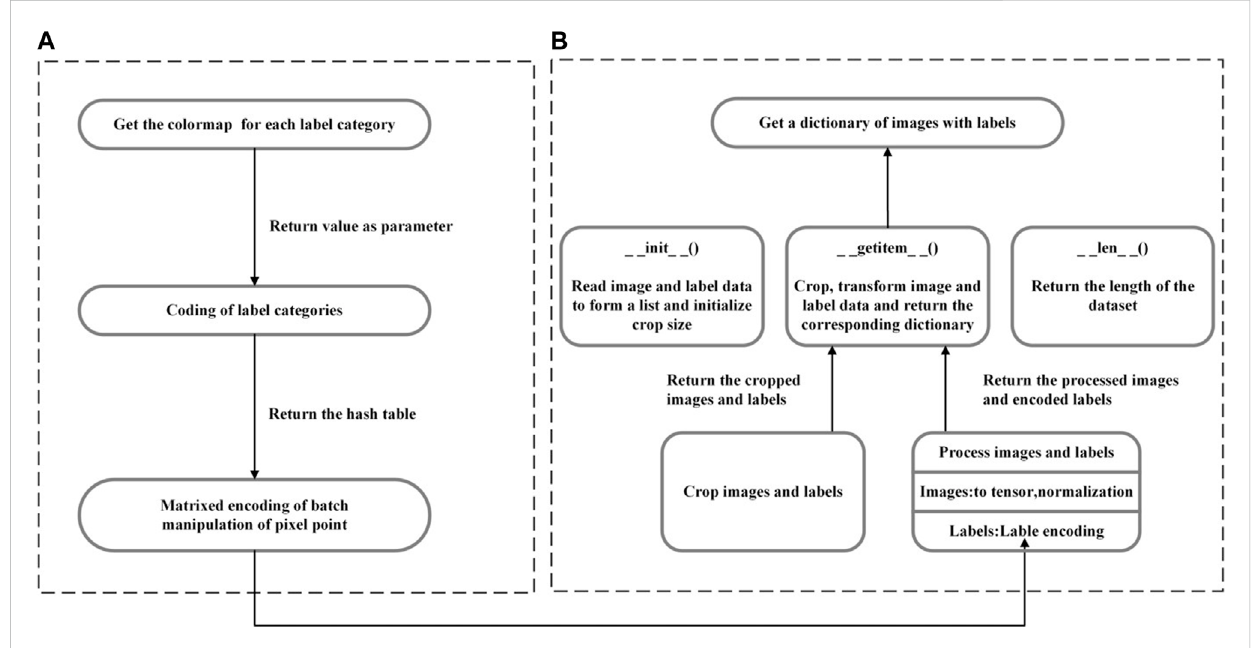
FIGURE 4 Data preprocessing process: (A) label processing and encoding; (B) initializing the